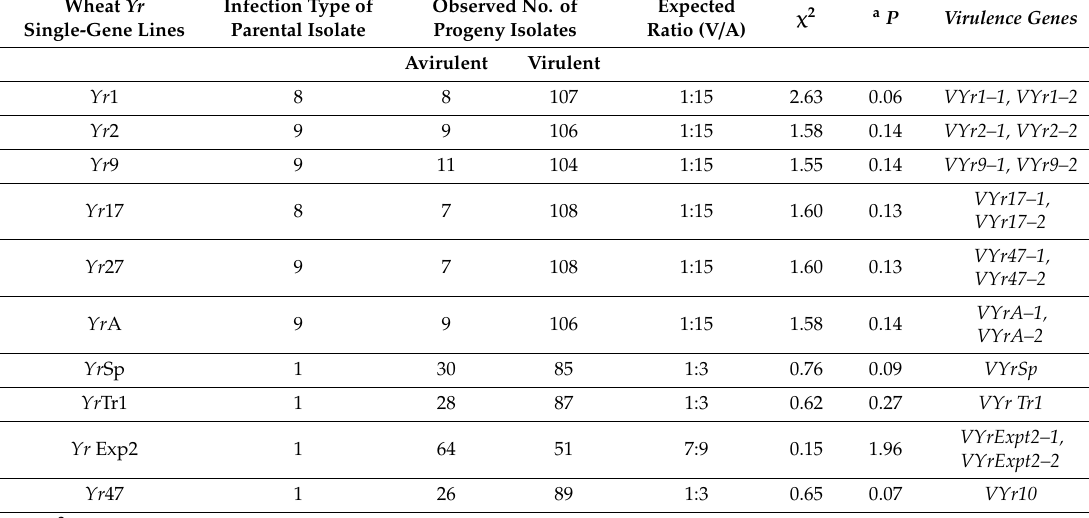
Table 2. Infection types, avirulence / virulence segregation in the progeny isolates obtained from selfing a Pakistani isolate of Puccinia striiformis f. sp. tritici on wheat Yr single-gene lines, and their probability ( P ) values of Chi squared tests for goodness of fit to the observed to the theoretical ratios. Wheat Yr Infection Type of Observed No. of Single-Gene Lines Parental Isolate Progeny